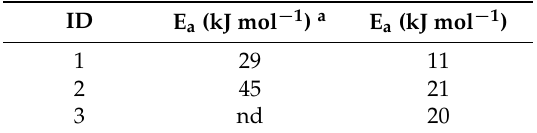
Table 2. Energies of activation recorded by AC Impedance and 7 Li longitudinal relaxation (T 1